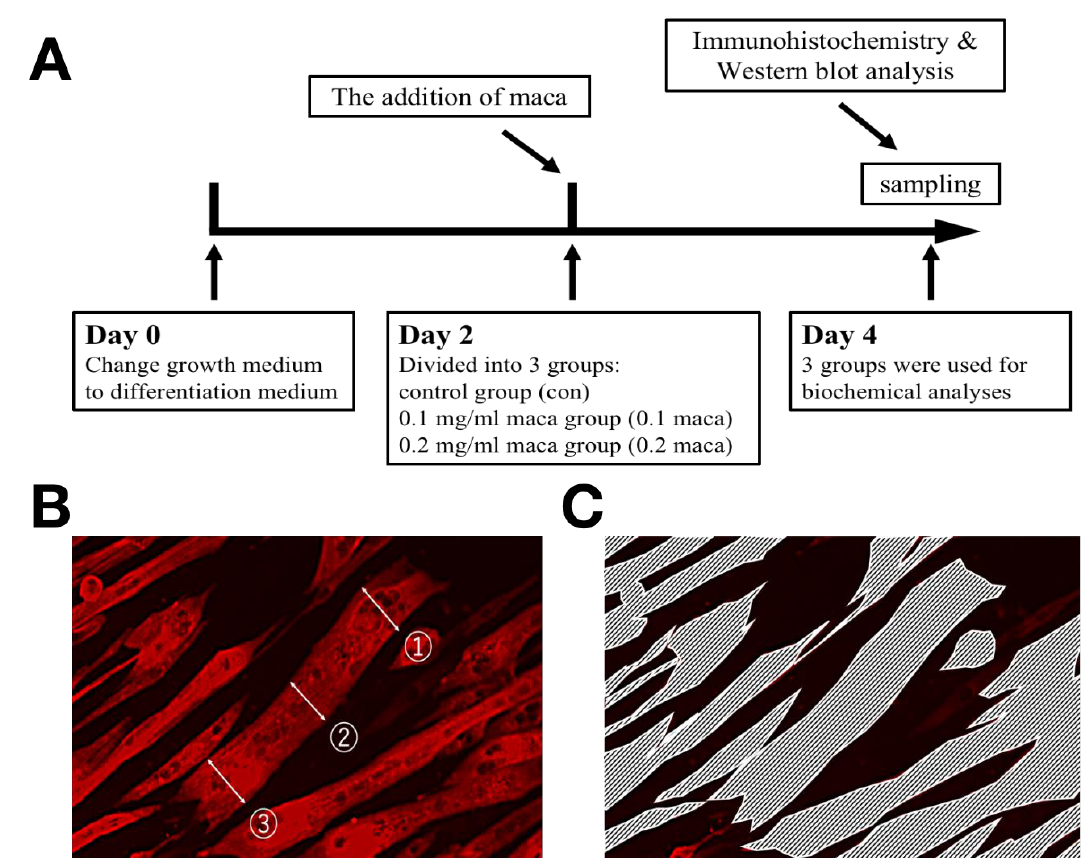
Figure 4. Experimental scheme ( A ) and methods for measuring myotube cell diameter ( B ) and area ( C ) in the experiments.